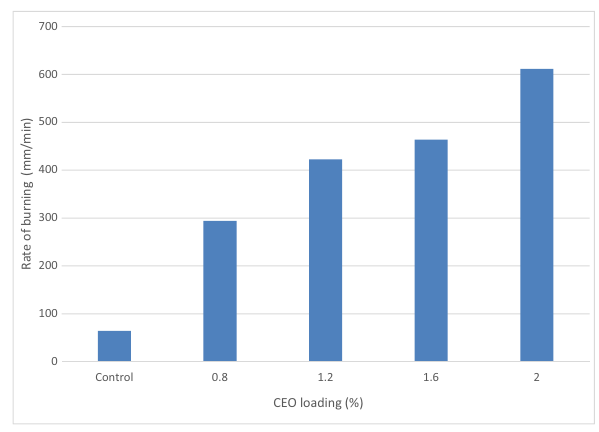
Figure 5: The e ff ect of di ff erent CEO loadings on the fl ammability of SPN/SPS biocomposite fi